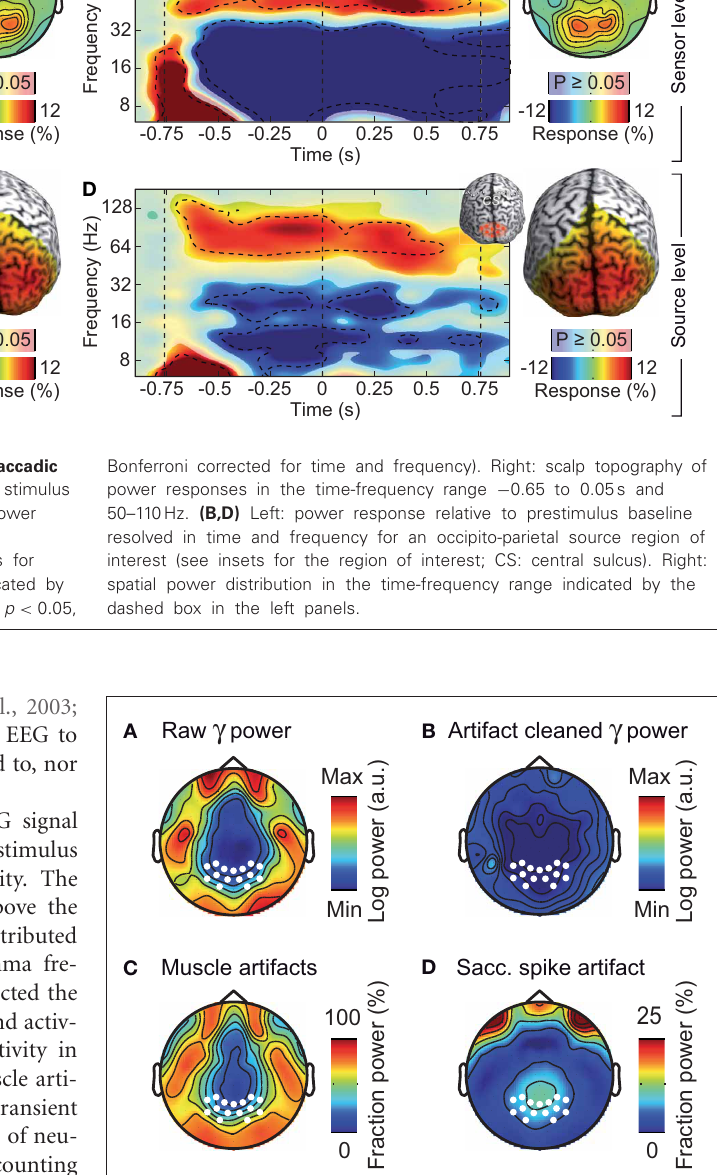
FIGURE 9 | Composition of EEG activity in the gamma-band. (A) Scalp distribution of raw pre-stimulus power in the gamma frequency band (50–100Hz) without ICA cleaning or spike potential rejection. White marks indicate the location of the occipito-parietal electrodes used in all other sensor-level analyses. (B) Scalp distribution of pre-stimulus gamma power for artifact cleaned data (ICA based removal of saccadic spike and muscle artifacts). (C,D) Scalp topography of the fraction of pre-stimulus gamma power that was removed by ICA cleaning of muscular- and saccadic spike artifacts,